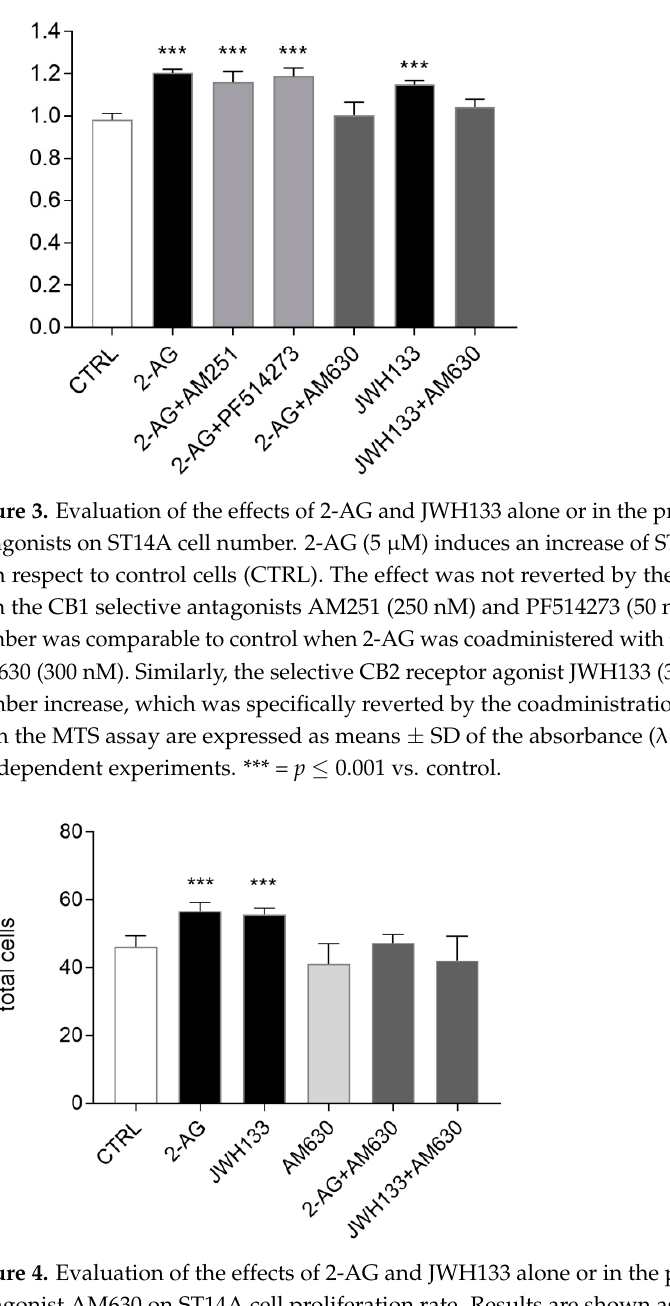
Figure 4. Evaluation of the effects of 2-AG and JWH133 alone or in the presence of the specific CB2 antagonist AM630 on ST14A cell proliferation rate. Results are shown as ratio (%) of the number of BrdU+ cells over the number of total cells, stained with DAPI fluorophore. After 24 h treatment with 2-AG (5 µM) and JWH133 (300 nM) an increase in BrdU incorporation was observed, with respect to untreated cells (CTRL); the effect was specifically reverted in both the cases by 300 nM